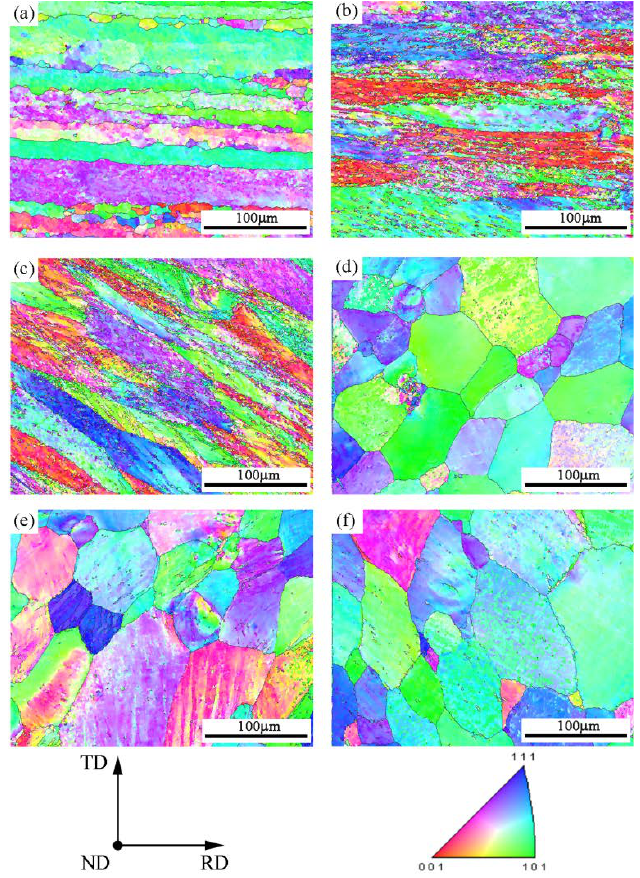
Figure 18. Orientation maps of AA6063 alloy samples before forming and in different observation position of boss section after forming: ( a ) initial blank, ( b ) position A, ( c ) position B, ( d ) position C, ( e ) position D, and ( f ) position E.